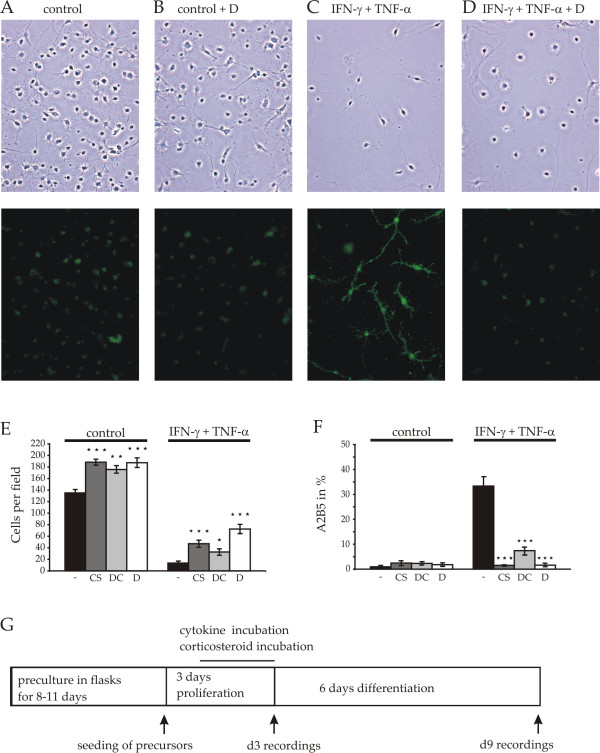
survival and A2B5 staining of oligodendrocytes following treatments with cytokines and corticosteroids. Phase contrast microphotographs as well as anti-A2B5 staining after three days in proliferation medium followed by 6 days in differentiation medium. Note, that after treatment of oligodendrocyte precursors with TNFα (10 ng/ml) and IFNγ (10 U/ml) for 48 h on 2–3 days in vitro (C) cells display mostly bipolar morphologies typical for progenitor cells, maintaining their A2B5 immunopositivity. Coapplication of dexamethasone during cytokine treatment (D) in the proliferation medium restored the extension of multipolar arborizations and the downregulation of A2B5 staining. (E) Average number of cells per field of view at culture day 9 (for every bar 25 fields of view from 12 coverslips of the control cultures and 4 coverslips of the corticosteroid treated cultures were counted). In both, control (left bars) and in cytokine-treated cells (right bars) corticosteroids caused a significant increase in the total number of cells surviving in culture. (F) Percentage of A2B5 positive cells at culture day 9. Note, that in control cells not treated with cytokines (left four bars) no significant effect of corticosteroids on the number of A2B5-positive cells was detected, whereas in cytokine-treated cultures the percentage of A2B5-positive cells was decreased by cotreatment with corticosteroids (CS: corticosterone, DC: deoxycorticosterone, D: dexamethasone, no corticosteroid treatment (-) * p < 0.05, ** p < 0.01, *** p < 0.001. For reasons of comparison the black bars in E and F are based on data published in [10], Figure 3B. Since cell counting was performed directly at the fluorescence microscope, fields of view were slightly larger than the photomicrographic frames shown. (G) Flow chart of the experimental design: After day 1 in proliferation medium, test cultures of oligodendrocyte precursors were treated for 48 hours with control proliferation medium or 10 U/ml IFN-γ and 10 ng/ml TNF-α in the presence or absence of glucocorticoids. The treatment was stopped by transferring the cells into differentiation medium. To judge long-term effects of treatments of precursor cells on subsequent differentiation most investigations were performed following 6 days in differentiation medium.